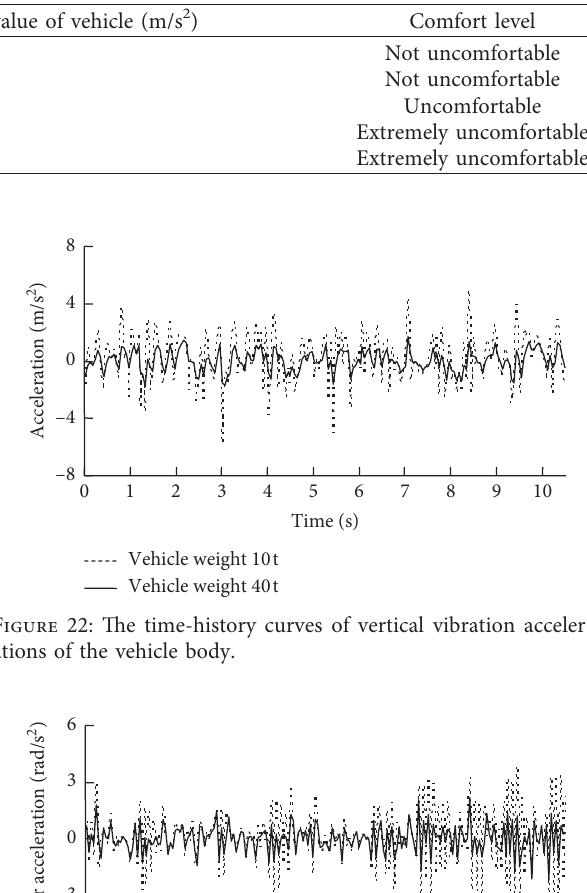
Table 3: The effects of vehicle speed on the vehicle ride comfort.